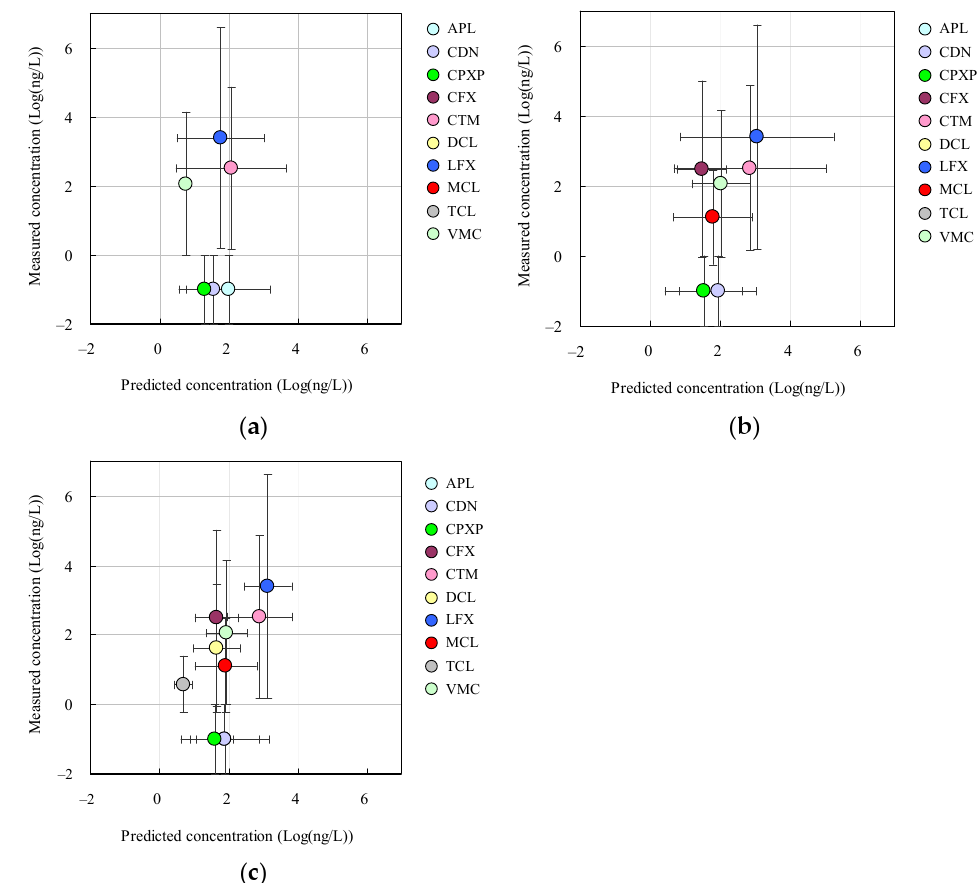
Figure 3. Relationship between correspondence ratios determined by using measured concentration values and the three types of predicted concentration values: ( a ) sales volume, ( b ) shipping volume, ( c ) NBD volume.